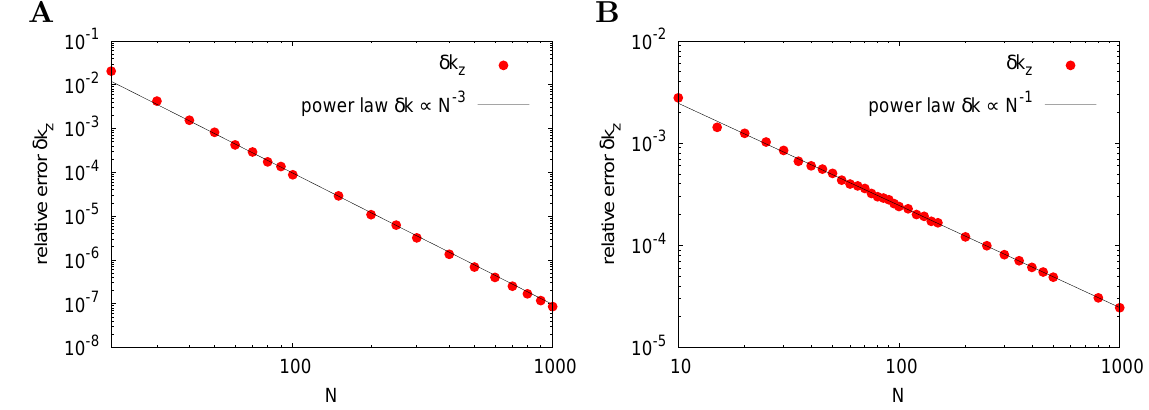
Figure 6. Convergence analysis for the smallest eigenvalue k for two different Bragg z mirrors coupled to normal and 25 ˝ incidence. ( A ) Normal incidence onto a Bragg mirror made of an alternating slicing of a high index material ( ε “ 12 ` 0 . 1 ı , µ “ 1 , 1 1 ζ “ 0 ) and a strongly left-rotating low index material ( ε “ 2 . 4 ` 0 . 01 j , µ “ 1 , 1 2 ζ “ 0 . 3 ı ) with respective thickness d “ 0 . 7 a and d “ 0 . 3 a . The reduced frequency 2 1 2 is set to ωa {p 2 πc q “ 1 . 8 . ( B ) Incidence at 25 ˝ onto a Bragg mirror defined by the domain parameters d “ 0 . 3 a , ε “ 6 ` 0 . 2 ı , µ “ 2 , ζ “ 0 . 5 ı and d “ 0 . 7 a , ε “ 1 , µ “ 1 , 1 1 1 1 2 2 2